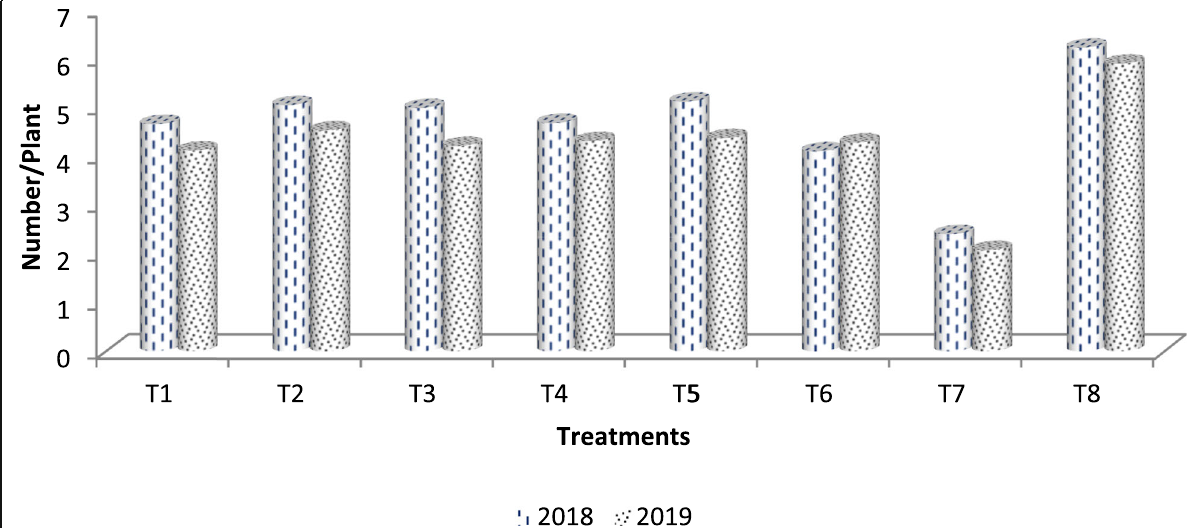
Fig. 1 Effect of different entomopathogenic fungi and neem oil alone and their combination (1:1) against Menochilus sexmaculatus